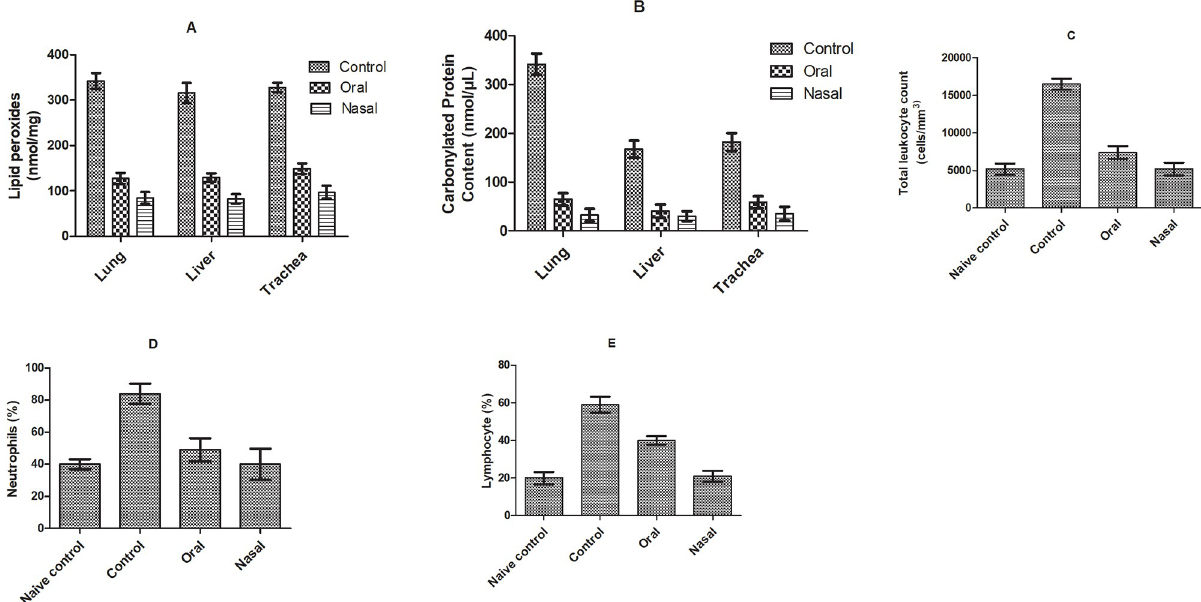
Fig 3. The effect of bromelain solution administered orally and nasally on oxidative stress markers (A) LPO level, (B) carbonylated protein content; and hematological immune response modulators (C) total leukocyte count (D) neutrophil (E) lymphocyte in lung, liver and trachea respectively in acute bronchospasm